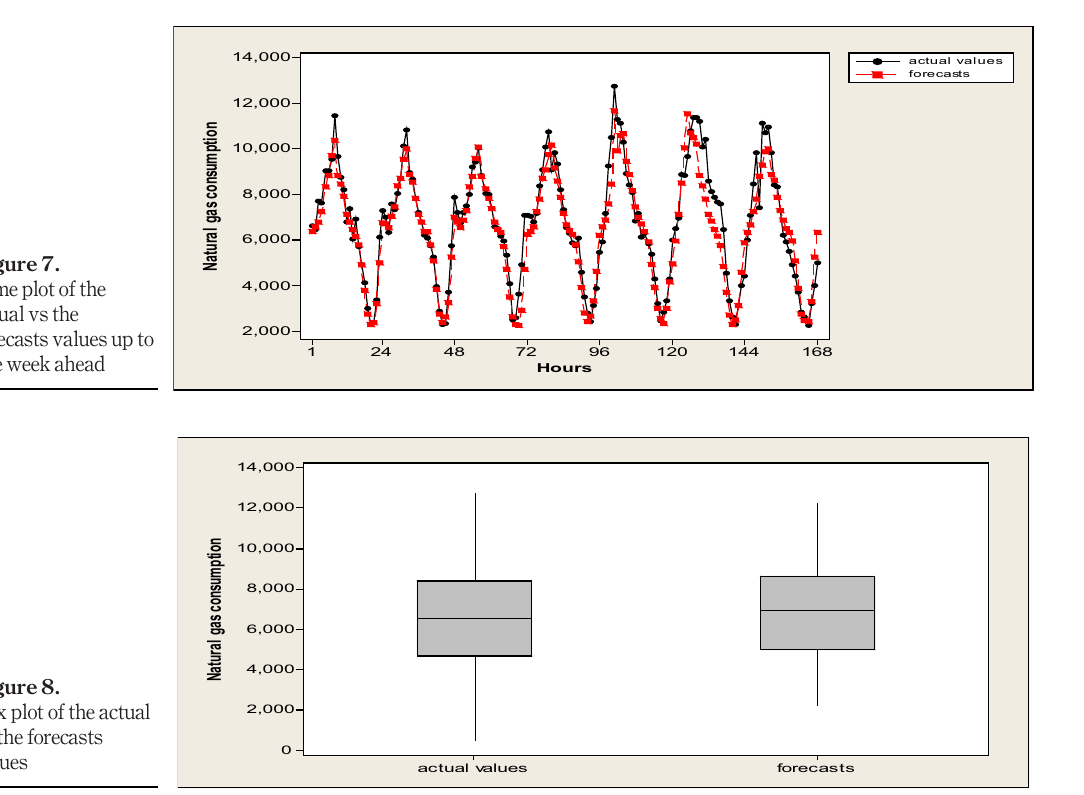
Figure 8. Box plot of the actual vs the forecasts values